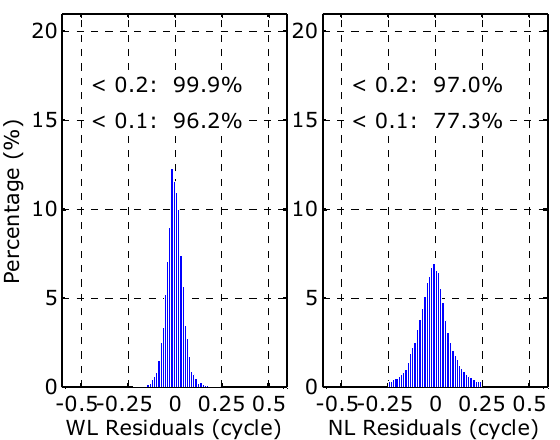
Figure 4. Distribution of a posteriori residuals of the WL and NL float ambiguities when performing GLONASS WL inter-frequency code bias (IFCB) calibration. Receivers with homogeneous type are used as rover sites.